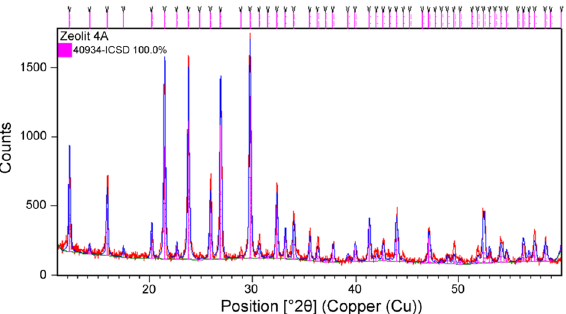
Figure 1. Rietveld structural refinement on synthetic zeolite Z4A. Experimental data are shown in red, while the calculated pattern is given in blue. Magenta vertical lines denote Bragg reflection positions according to the 40934-ICSD standard for 4A zeolite